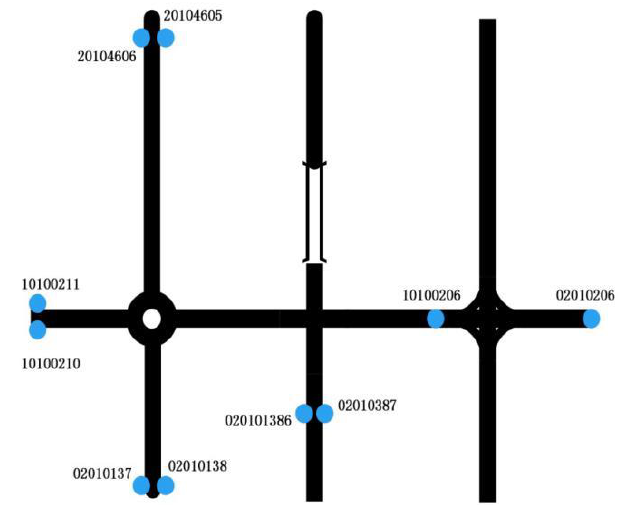
Figure 5. Distribution and ID of intersections in the testing road network.